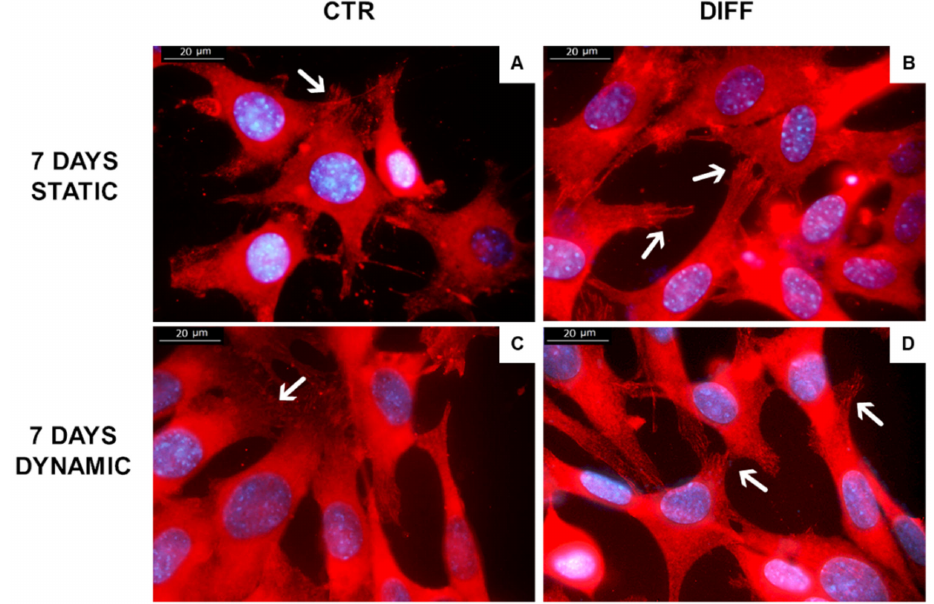
Figure 8. Expression and distribution of vinculin (red) staining in H9c2 cells cultured in static ( A , B ) and dynamic ( C , D ) conditions (5% substrate deformation, 1 Hz frequency). The experiments were repeated three times. Representative immunofluorescence micrographs are shown. White arrow indicate vinculin in focal adhesions. Scale bar: 20 µ